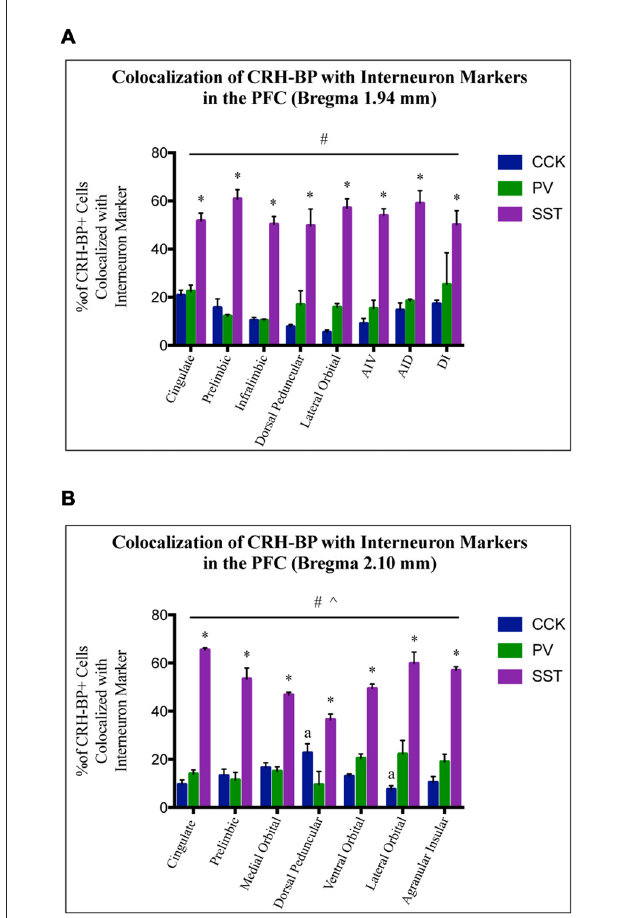
FIGURE 4 | CRH-BP mRNA colocalizes predominantly with SST interneurons in the PFC. Quantification of CRH-BP mRNA colocalization with CCK, PV and SST in the caudal PFC ( A , Bregma coordinate 1.94 mm) and a more rostral region of the PFC ( B , Bregma coordinate 2.10 mm). Data represent the percentage of CRH-BP-positive cells colocalized with interneuron marker. Data for the colocalization between CRH-BP and VIP is not shown, as colocalization was barely detectable (see text). There was a significant main effect of cell type ( # p < 0.0001) at both Bregma coordinates (A,B) . Post hoc analyses showed that the colocalization between CRH-BP and SST was significantly higher than the colocalization of CRH-BP with CCK, PV, or VIP in all subregions of the PFC at both Bregma coordinates ( ∗ p < 0.01 compared to CCK, PV and VIP). ˆ p < 0.0001 interaction. a p < 0.05 compared to respective PV group. Data represent the mean ± SEM. AIV, agranular insular ventral; AID, agranular insular dorsal; DI, dysgranular insular.